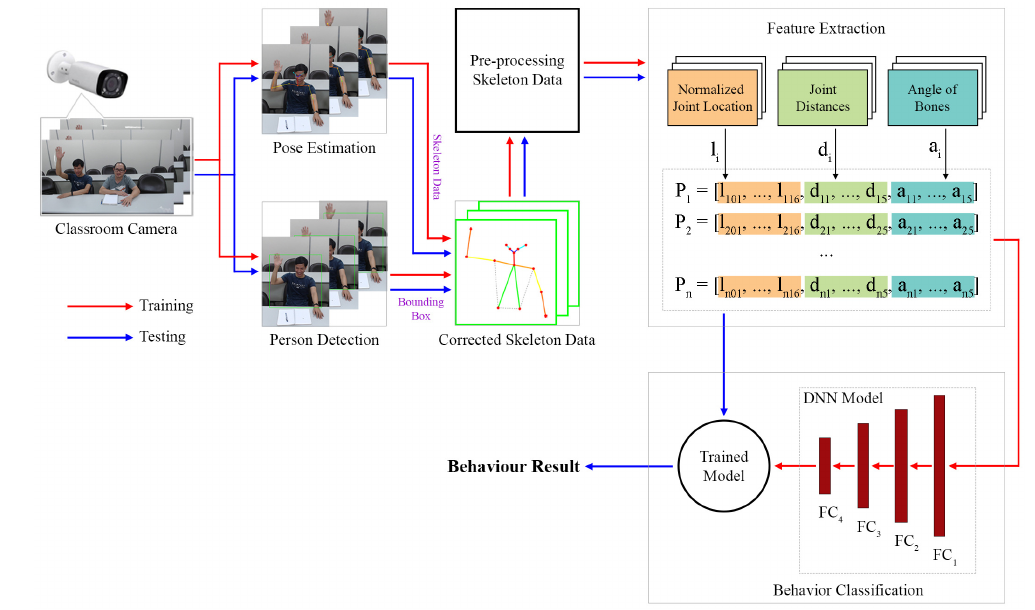
Figure 1. System